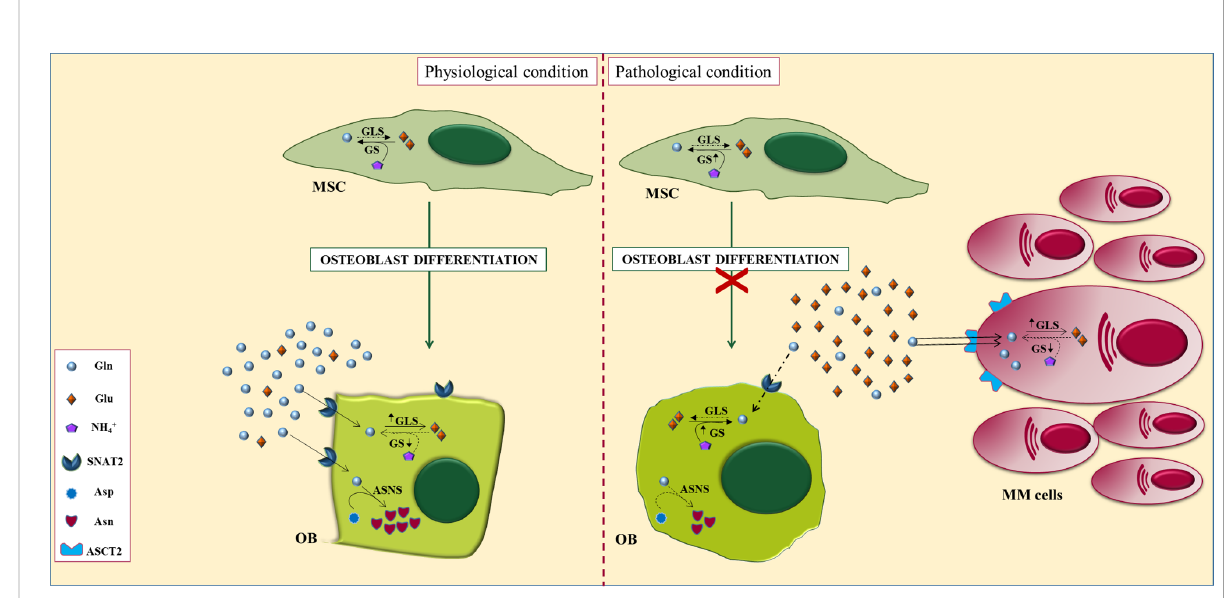
FIGURE 3 Alterations of glutamine metabolisms in myeloma bone niche. In physiological conditions (left), glutaminase and the concentric glutamine transporter SNAT2 are induced during osteoblastogenesis and are both required for the differentiation of mesenchymal stromal cells (MSCs), indicating an increased requirement for the amino acid. Osteoblastogenesis also triggers the induction of glutamine-dependent asparagine synthetase (ASNS). However, under pathological conditions (right), Gln-dependent MM cells downregulate Gln in the BM microenvironment leading to defective differentiation of OBs, attributable, at least in part, to impaired Gln-dependent Asn